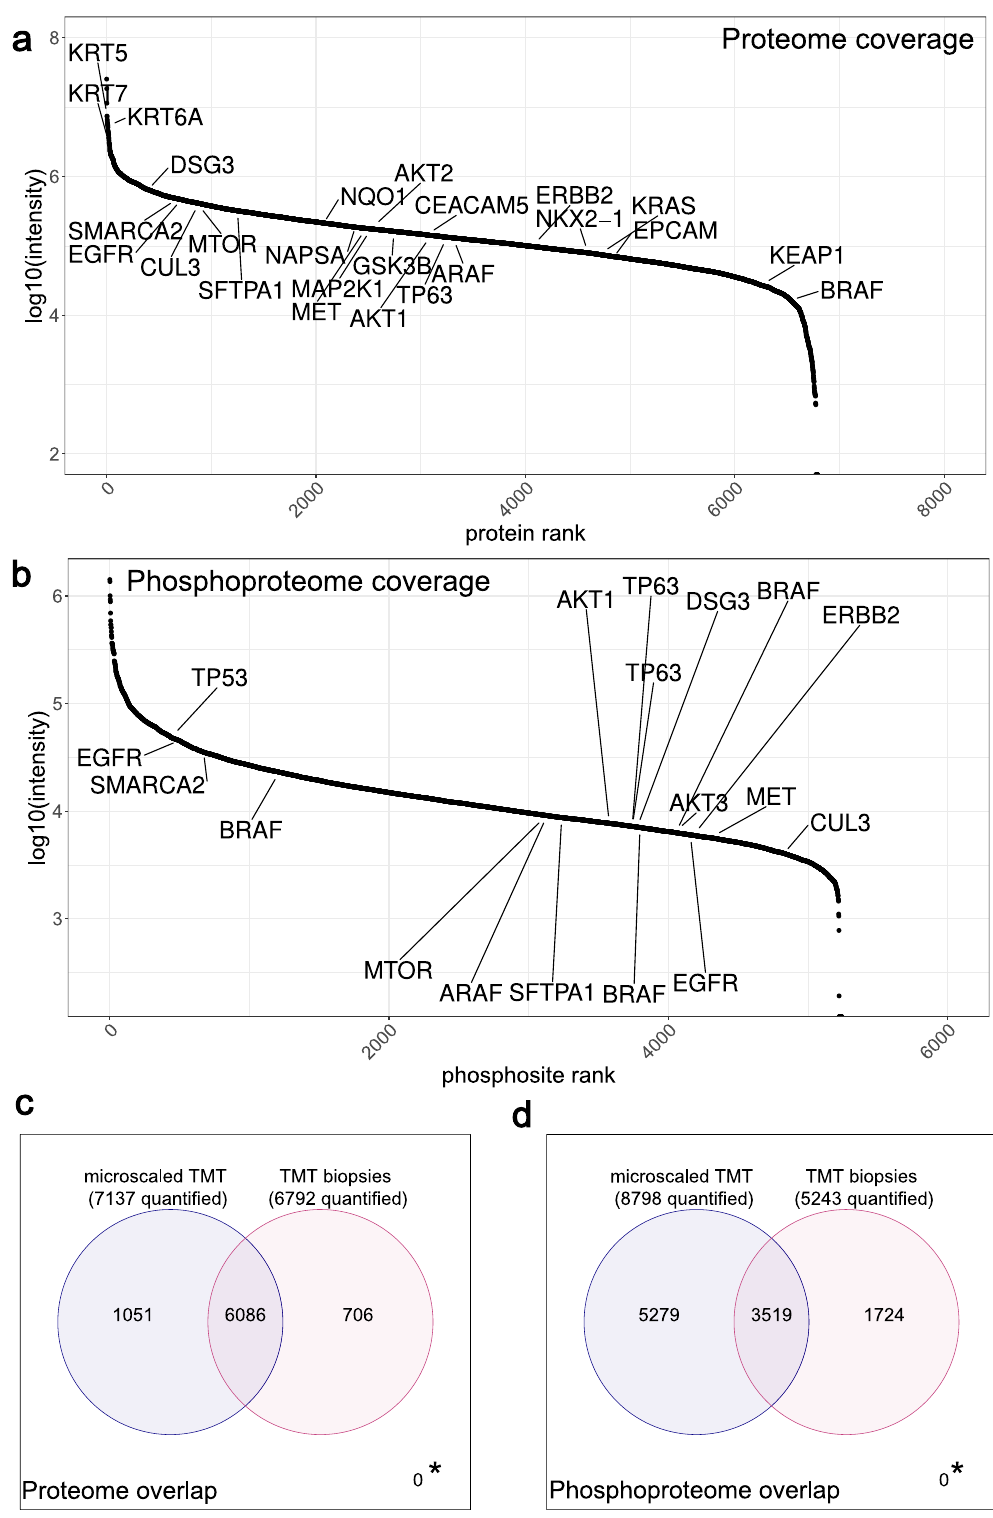
Fig. 5 Deep proteome and phosphoproteome from FFPE needle biopsies. a Log10 reporter ion intensity distribution over all proteins that were quanti fi ed in TMT biopsies. Source data are provided as a Source Data fi le. b Log10 reporter ion intensity distribution over all phosphosites that were quanti fi ed in TMT biopsies. Source data are provided as a Source Data fi le. c Venn diagram showing the overlap of quanti fi ed proteins between microscaled TMT and TMT biopsies. Only unique proteins and no isoforms were counted as quanti fi ed proteins. * marks proteins not quanti fi ed with either method (0). d Venn diagram showing the overlap of quanti fi ed phosphosites between microscaled TMT and TMT biopsies. * marks phosphosites not quanti fi ed with either method